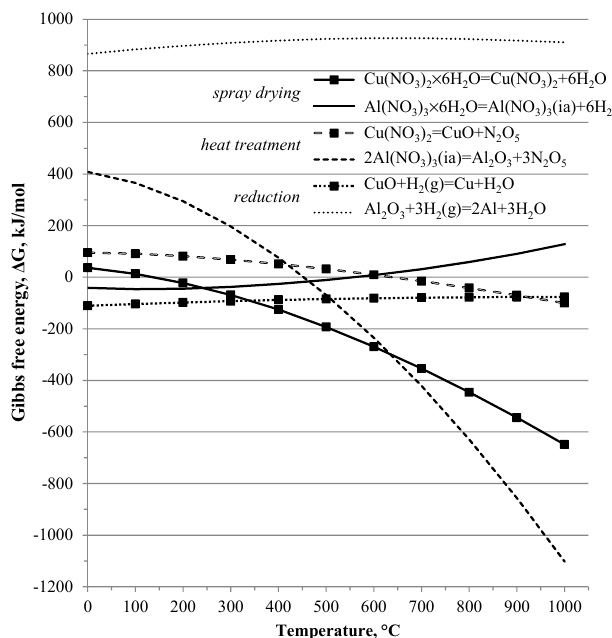
Figure 2. Gibbs energy of reactions versus temperature.